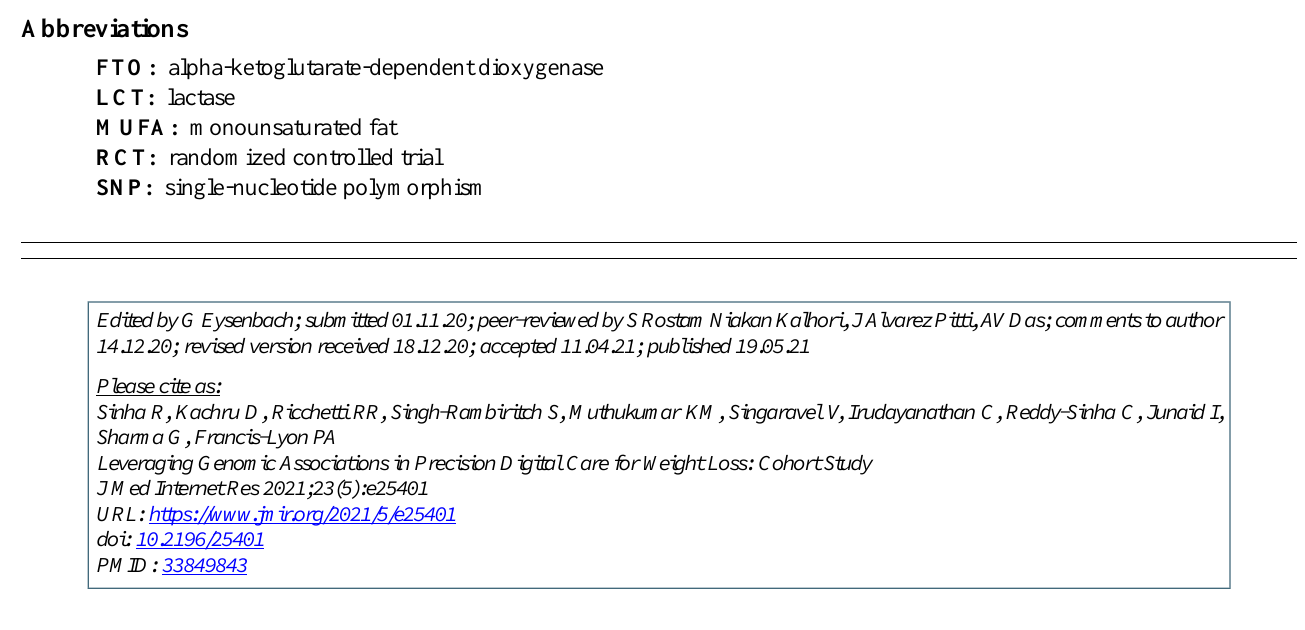
124. Heianza Y, Qi L. Gene-diet interaction and precision nutrition in obesity. Int J Mol Sci 2017 Apr 07;18(4):787 [FREE Full